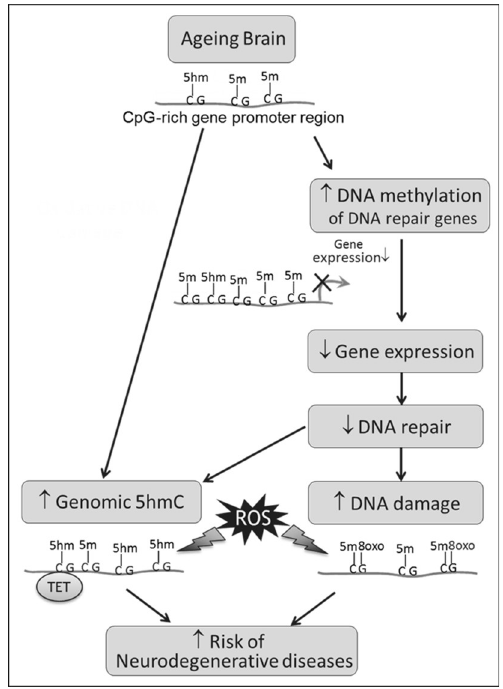
Figure 1. Schematic overview of the study hypothesis. Abbreviations used: 5mC, 5-methylcytosine; 5hmC, 5-hydroxymethycytosine; 8-oxodG, 8-oxo-7,8-dihydro-2′-deoxyguanosine; ROS: reactive oxygen species; TET: ten-eleven translocation enzymes.